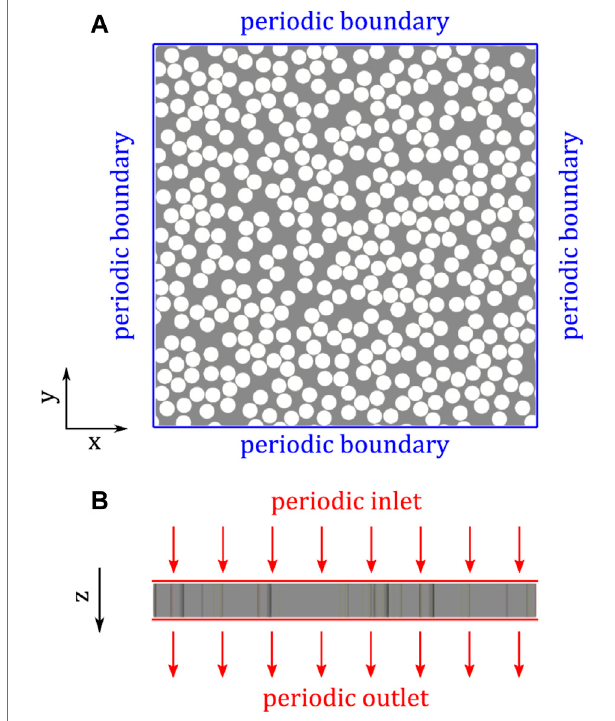
FIGURE 9 | Simulation model with periodic boundaries for axial simulations; view parallel (A) and transverse (B) to the fi